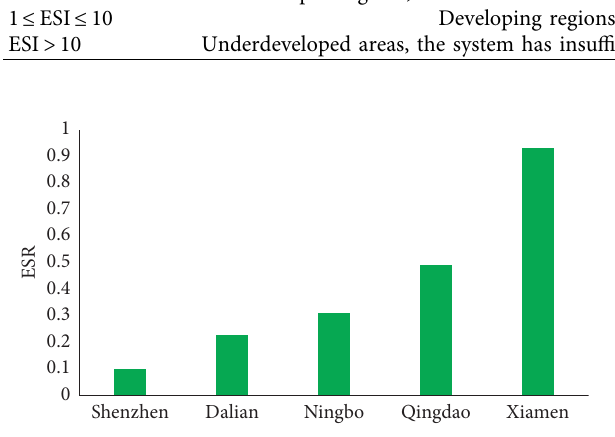
Figure 6: ESI of each city in